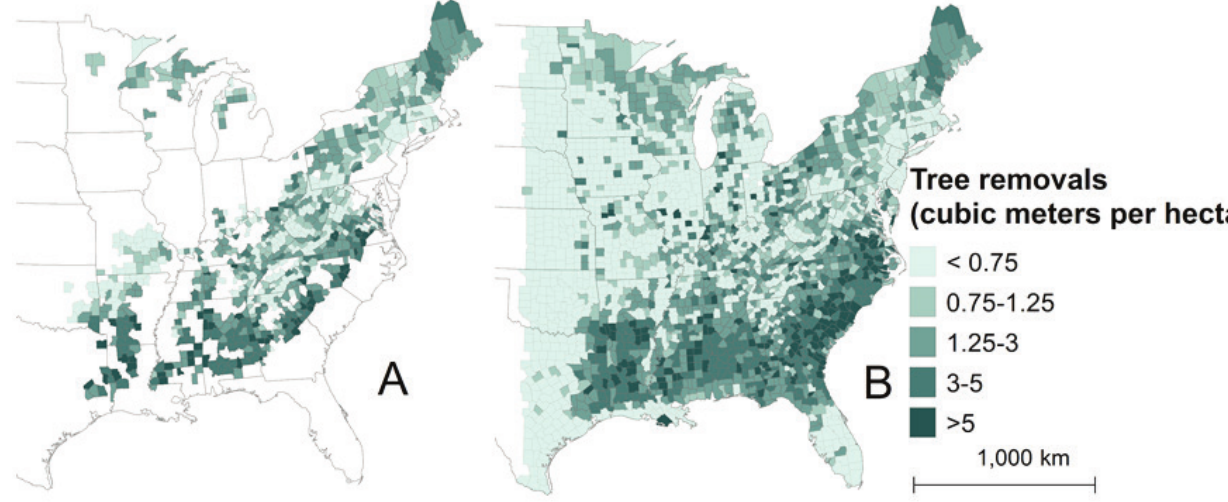
Figure 5. Average annual volume of tree removals (≥12.7 cm diameter; cubic meters/ha; Evalidator database; USDA Forest Service, Forest Inventory and Analysis Program 2021) by county in eastern forests (A) and the eastern United States